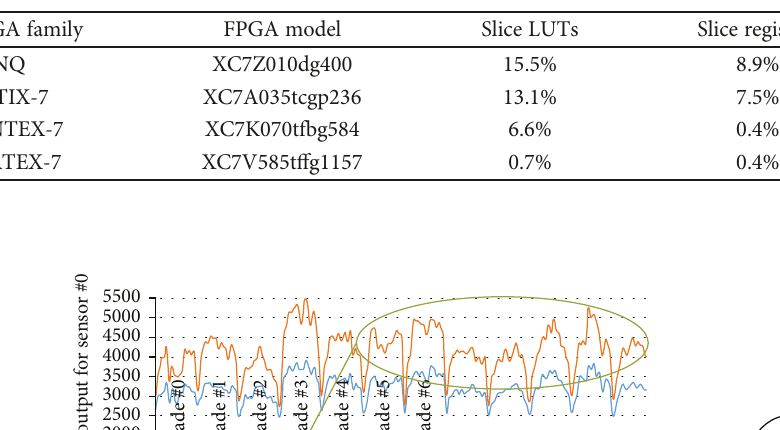
Table 4: Utilization percentage of the available resources in di ff erent FPGA families.